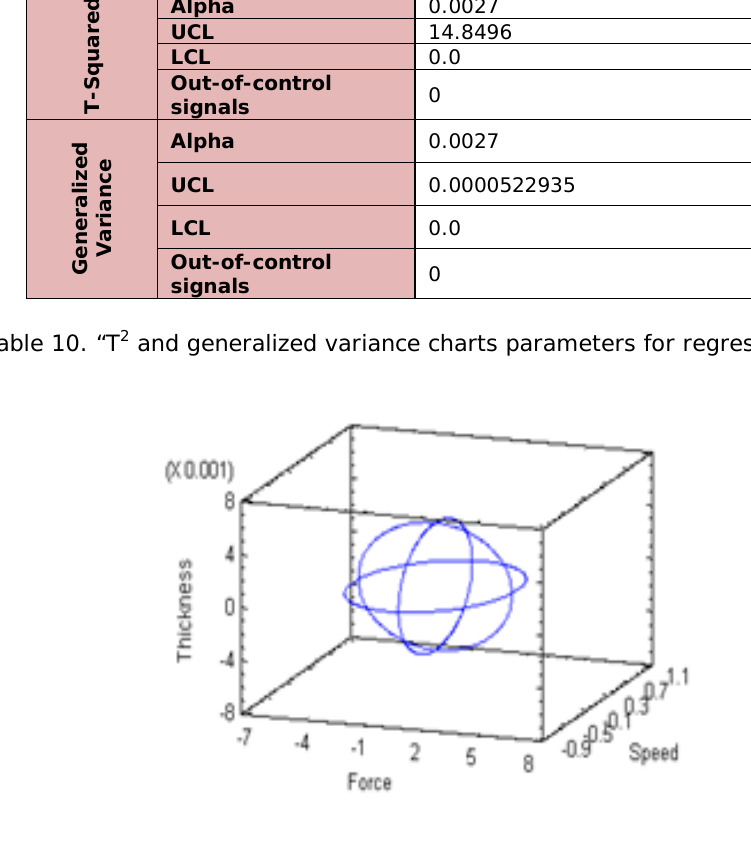
Figure 44. “Control ellipsoid for T 2 chart for the regressed